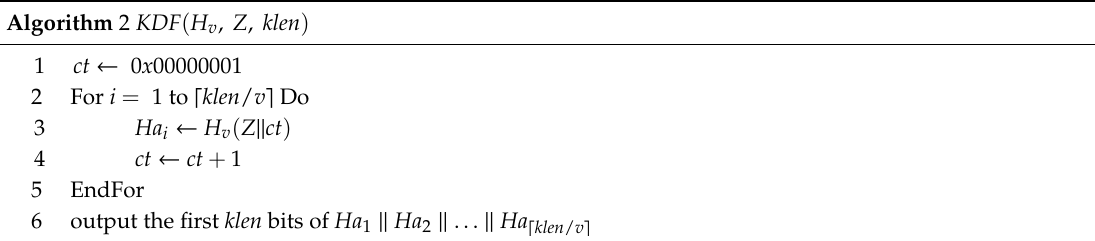
Algorithm 2 KDF ( H v , Z , klen )